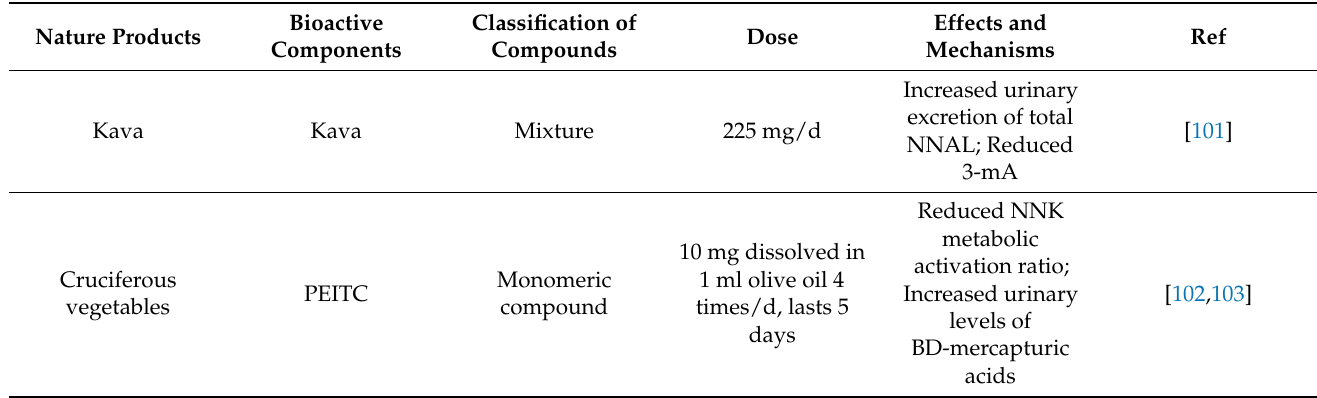
Table 2. Summary of the clinical trials describing dietary phytochemicals for lung cancer